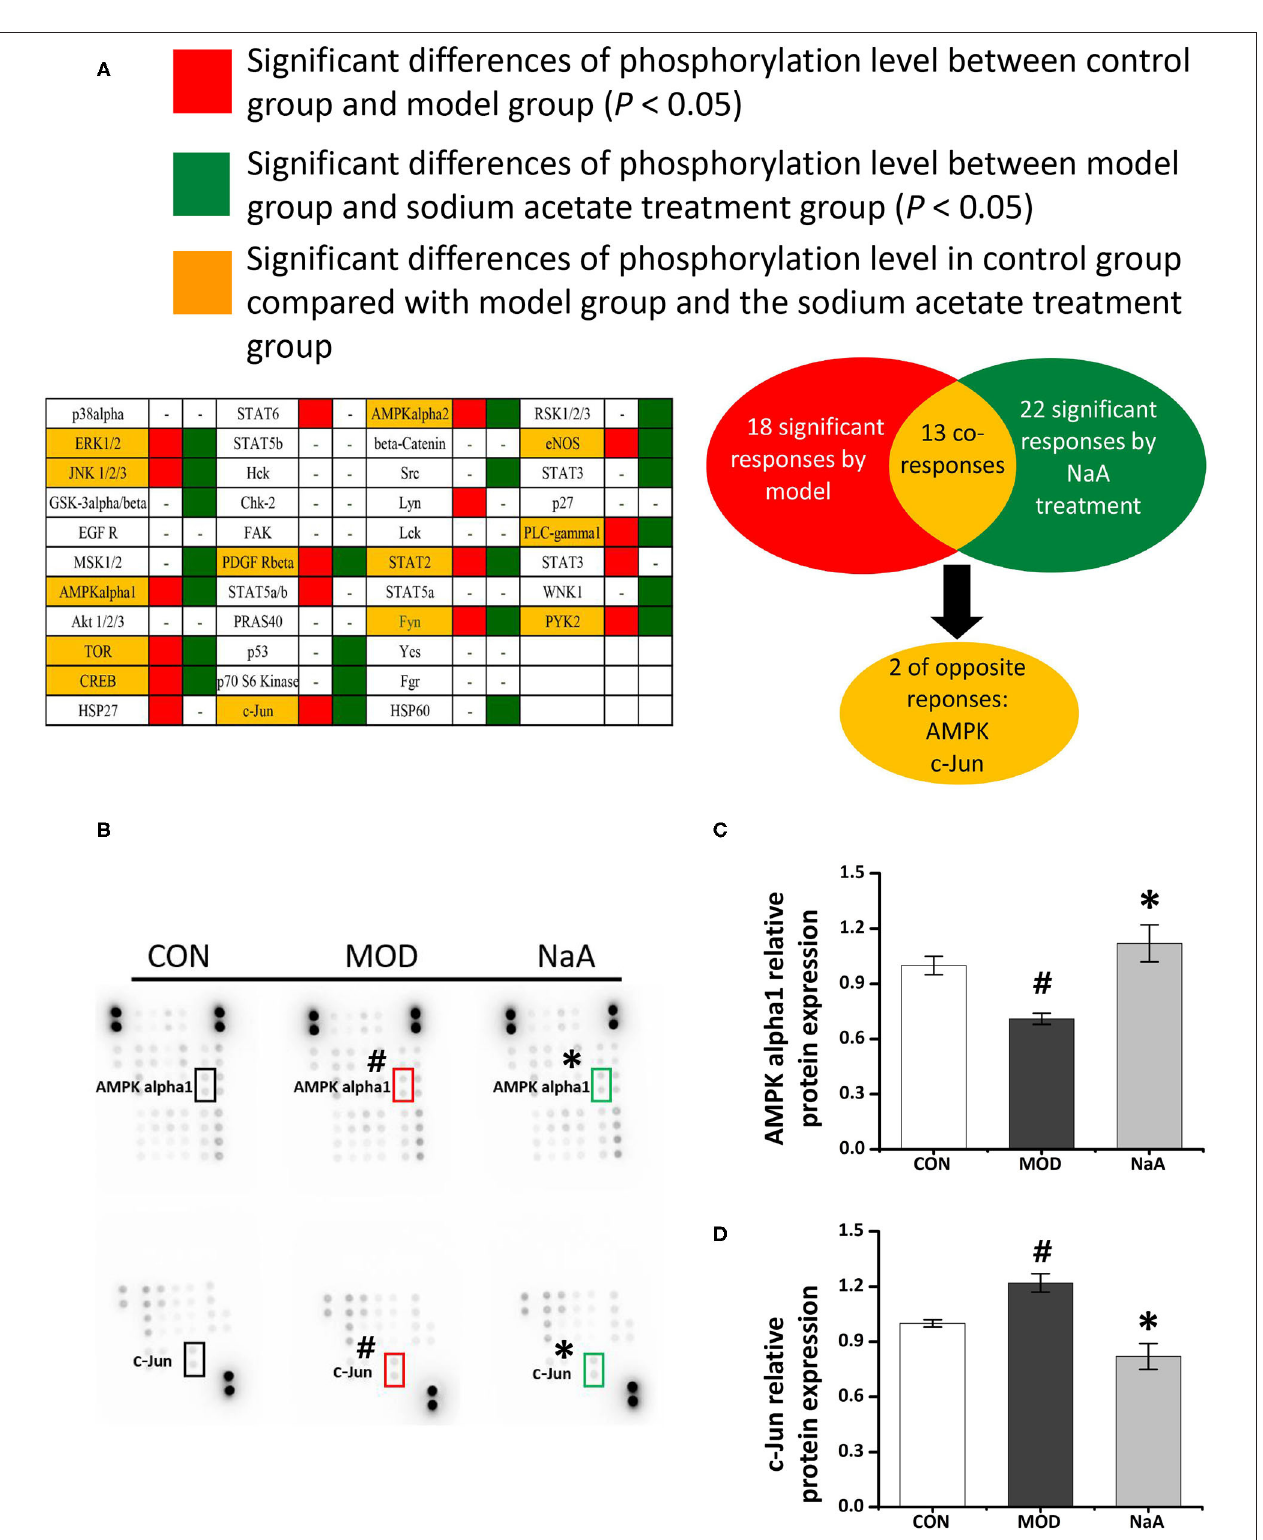
FIGURE 4 | Potential targets of NaA. LX2 cells were treated with or without 2.5ng/ml TGF- β 1 and 0–1mM of NaA for 48h. After quantitative analysis of the results using gray analysis software. (A) The component-target network. Phosphorylation analysis of 43 potential targets. 43 protein contains a protein called p53, protein p53 has three phosphate sites (s15, s392, and s46), we will uniform them as p53. The red represents to compare with the CON, the model is significantly different,